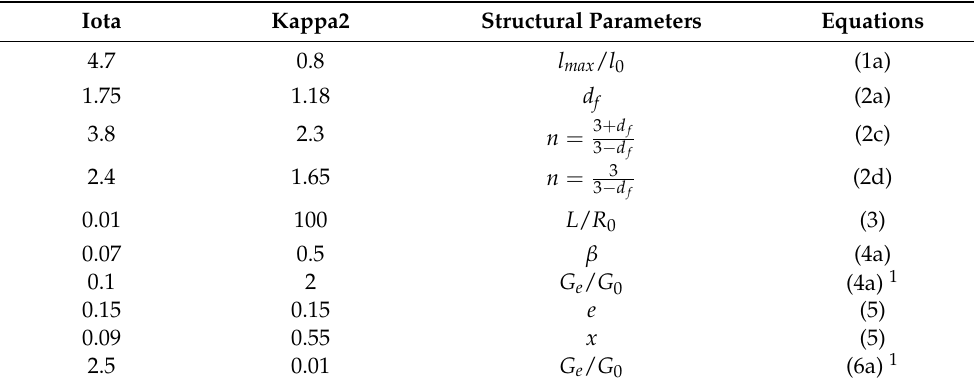
Table 5. Numerical values of the parameters used in the equations presented in Section 3 to compute G ( γ )/ G 0 data presented in Figure